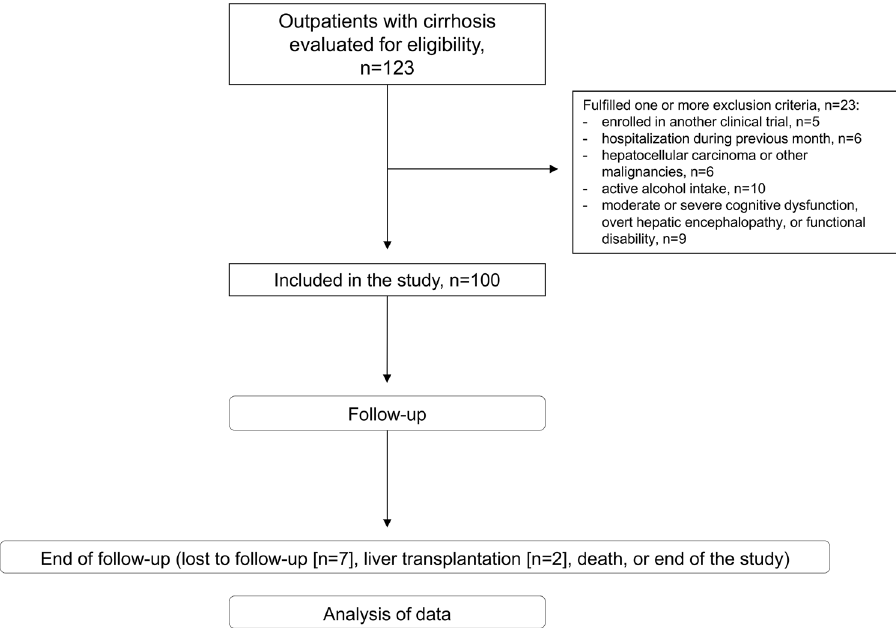
Figure 1. Flow-chart of the study.